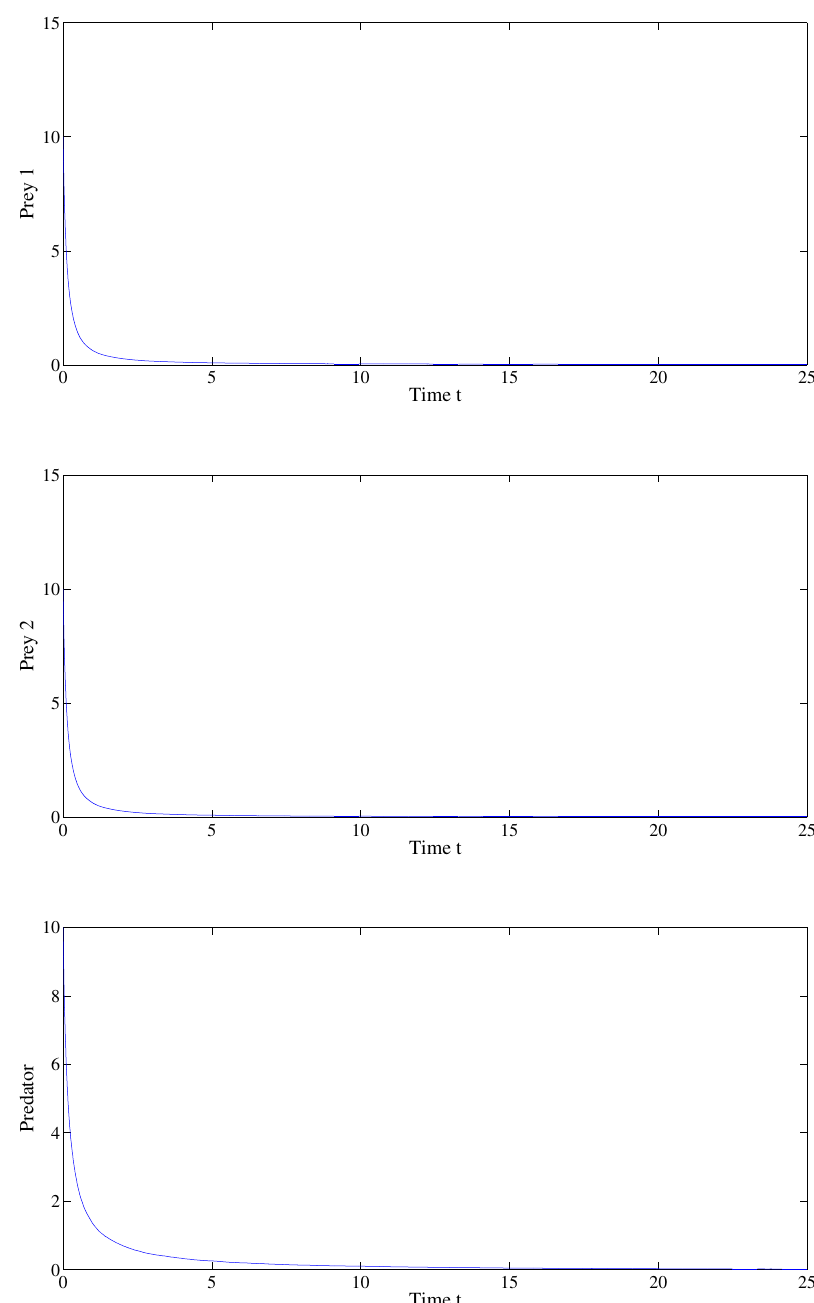
Figure 1. The behavior of the prey and predator populations in the extinction situation described by Theorem